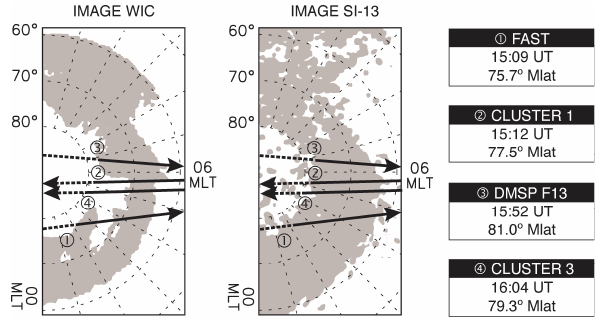
Fig. 14. A schematic summary of the distribution of UV auroras and FAST, DMSP F13, Cluster 1 and 3 overflights on 8 December 2001. In the satellite paths the transition from dashed to solid line indicates the transition from open to closed field lines (PC-boundary). The gray silhouette shows the UV aurora distribution at 15:19:49 UT the times and the PC-locations of the satellite overflights are given in the numbered boxes. (From Wild et al., 2004.)